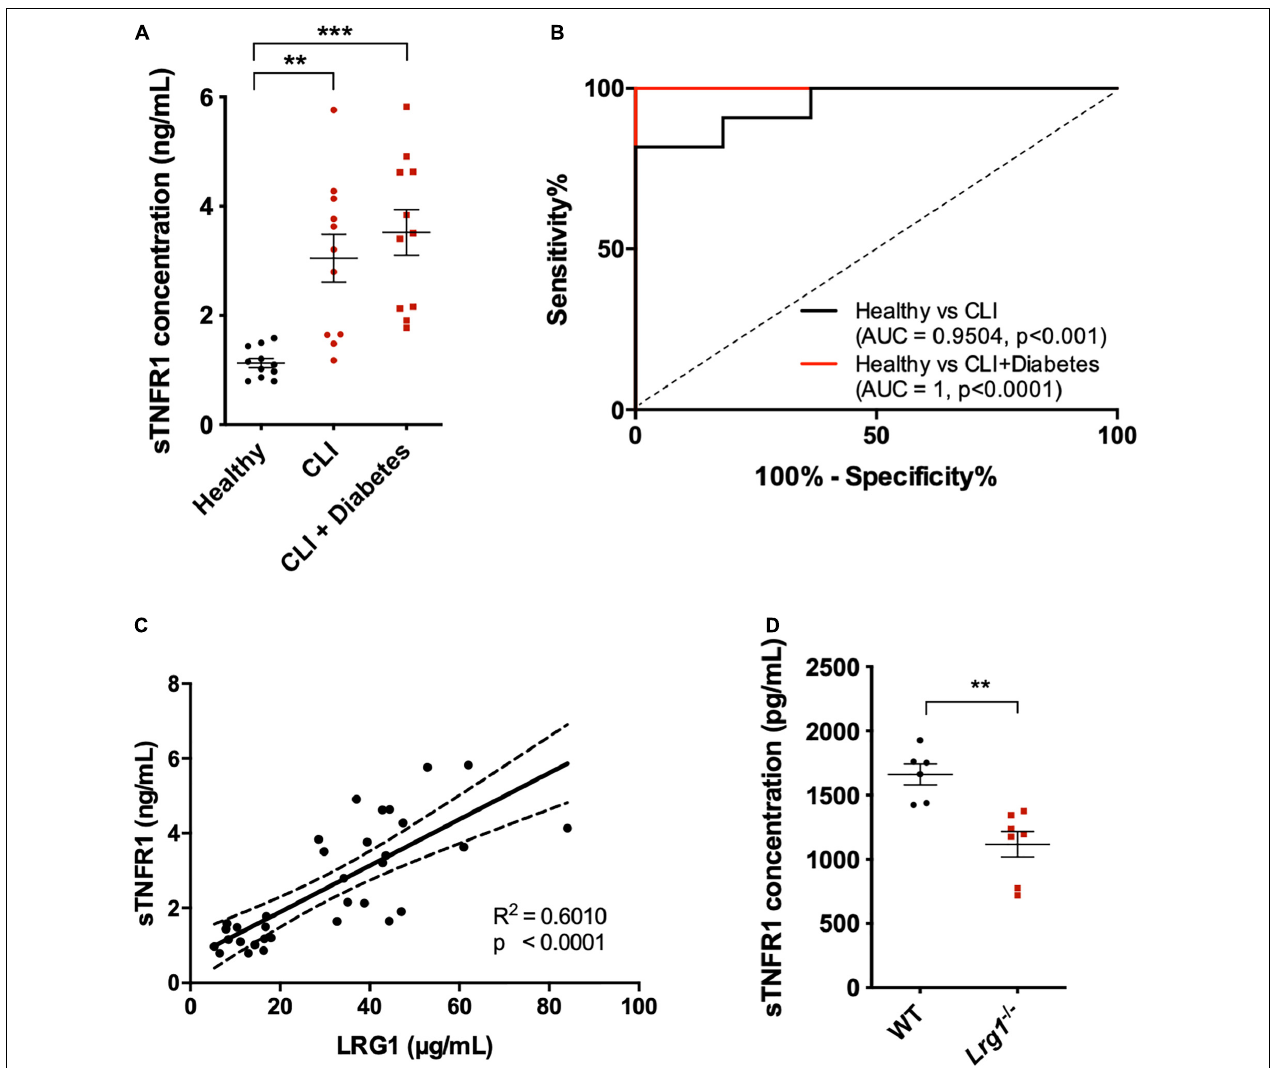
FIGURE 6 | Soluble TNFR1 (sTNFR1) was upregulated in the serum of CLI patients and was correlated with LRG1 expression. (A) ELISA measurement of sTNFR1 concentration in healthy controls and CLI patients (with and without diabetes). sTNFR1 was significantly higher in the serum of CLI patients (with and without diabetes) compared to healthy controls. (B) Receiver Operating Characteristic (ROC) curve analysis of the ability of serum sTNFR1 to differentiate between healthy controls and CLI patients, and between healthy controls and CLI patients with diabetes. (C) The concentrations of sTNFR1 and LRG1 in healthy controls and CLI patients were significantly correlated. (D) ELISA measurement revealed that the concentration of sTNFR1 in the serum of 37-week-old Lrg1 − / − mice was significantly lower than that in the serum of wild-type counterparts. [ (A) , One-way ANOVA followed by Bonferroni post hoc test; n = 11/group. (C) , Linear regression analysis, n = 33; Dashed lines indicate the 95% confidence intervals for the regression line. (D) , Unpaired two-tailed Student’s t -test; n ≥ 6. ** p < 0.01; *** p <